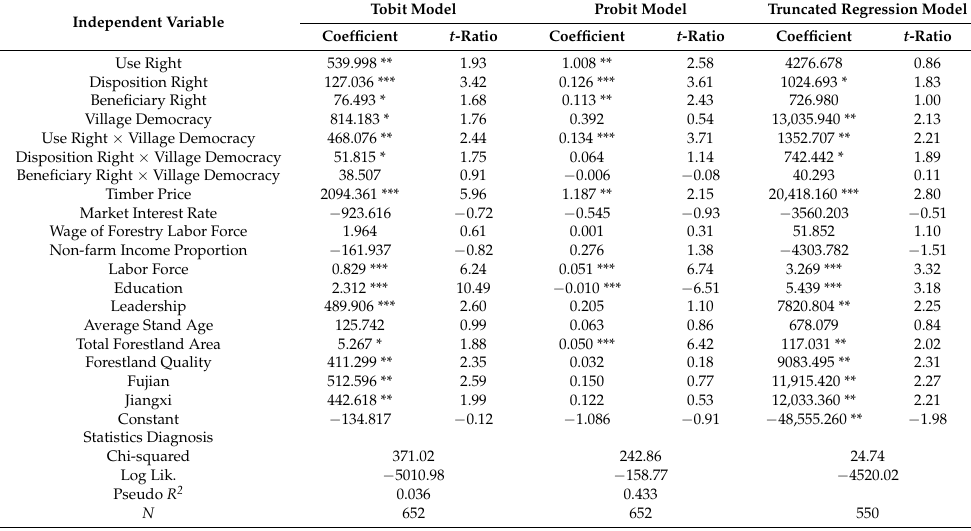
Table 2. Estimation results: Tobit and Cragg models for the probability and quantity of labor investment.